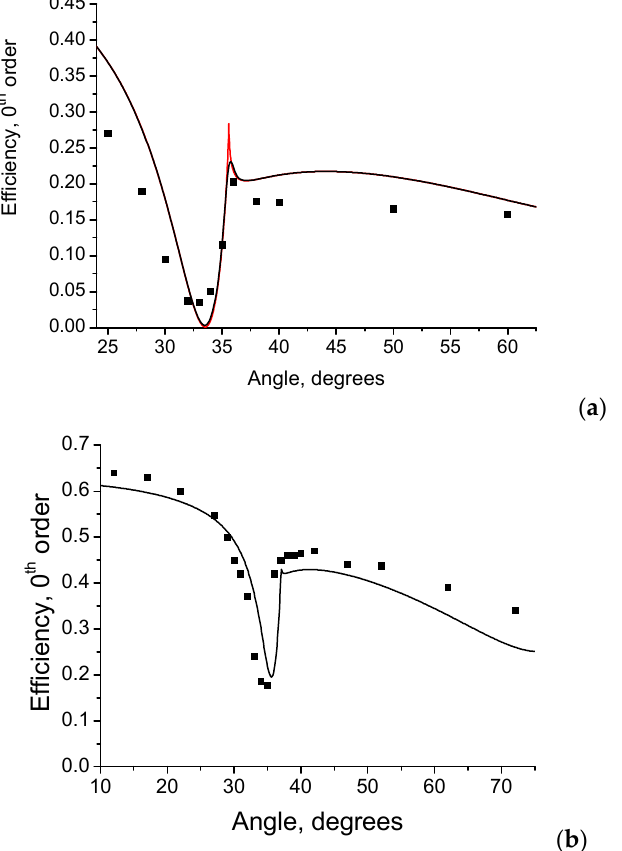
Figure 4. Calculated (solid lines: red—plane wave, black—Gauss beam with FWHM = 32 μ m) and measured diffraction efficiencies of the zero-order depending on the incidence angle for the nickel grating with a period Λ = 400 nm and depths h = 80 nm ( a ) and h = 40 nm ( b ) at a wavelength of radiation 𝜆 = 632.8 nm with p -polarization.